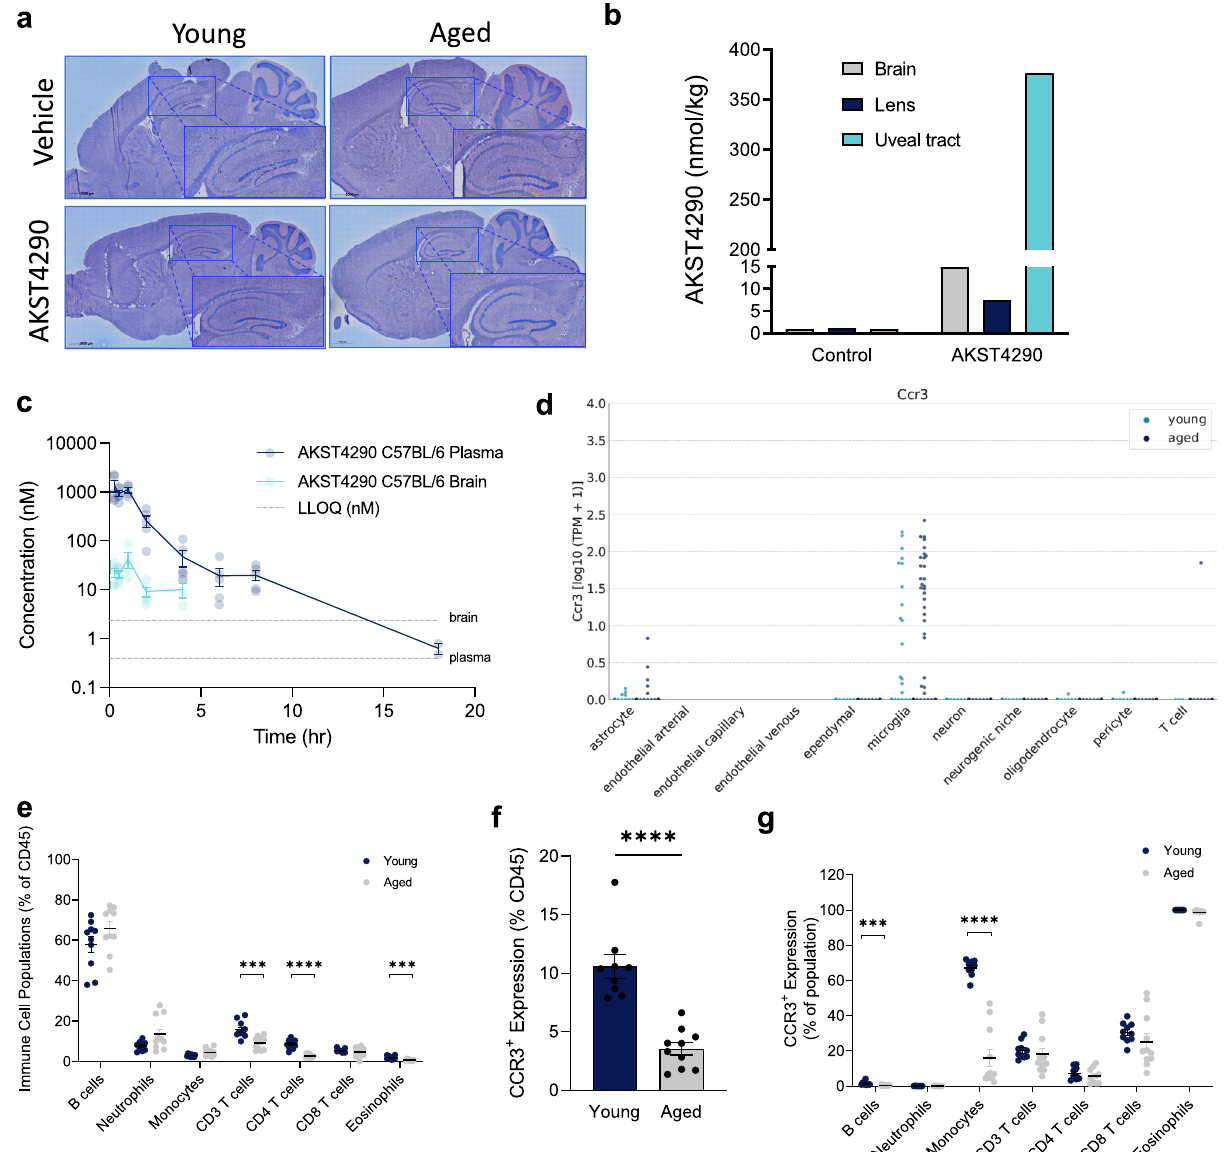
Fig. 2 CCR3 is primarily expressed in the periphery and is modulated in aging. a Representative images from microautoradiography (MARG) analysis of brain tissue 2 h following treatment with 30 mg/kg [ 14 C]-AKST4290 p.o. b Quanti fi cation by autoradiography (ARG) of various tissues in an aged